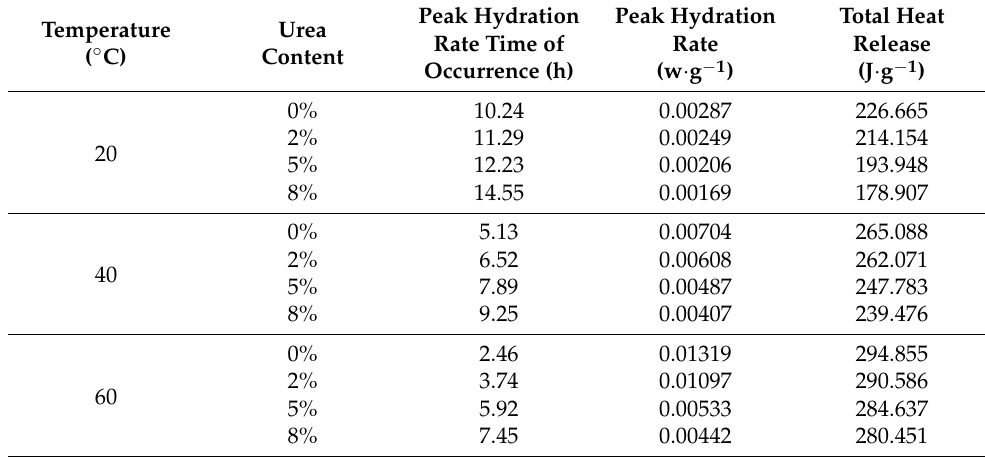
Figure 2. Hydration rate and cumulative heat release graph. Their values are shown in Table 4. Table 4. Rate of hydration and total cumulative heat release of hydration.